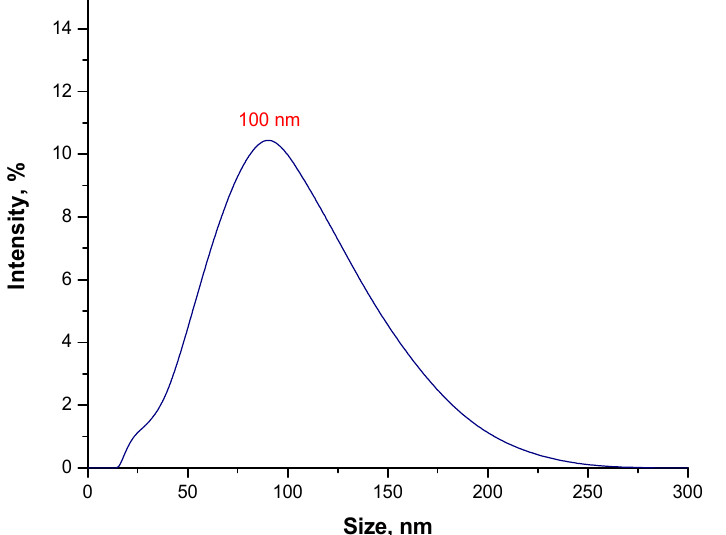
Figure 6. The size analysis of Fe 3 O 4 @Au particles obtained in the water environment and subjected to 6 h sonication.